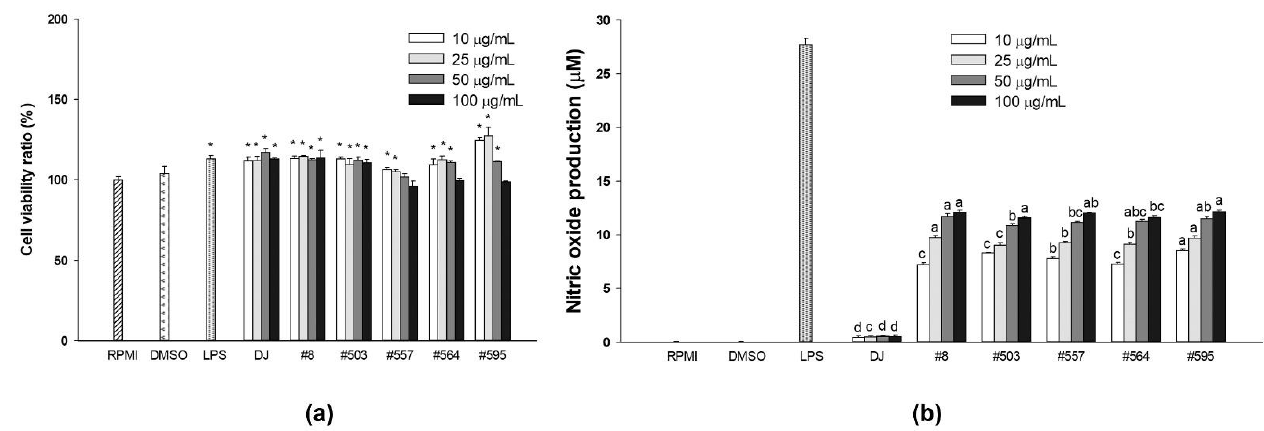
Figure 3. Effects of transgenic rice extracts on RAW264.7 cells without LPS stimulation. Effects on ( a ) cell viability and ( b ) NO production. The concentrations of DMSO and LPS were 0.1% and 1 µg/mL, respectively. Data are presented as means ± standard deviations. Significant differences at p value of <0.05 (*) were determined via comparisons with the RPMI group. Lowercase letters (a, b, c, and d) indicate significant differences at p value of <0.05 among treatments at the same concen- tration.